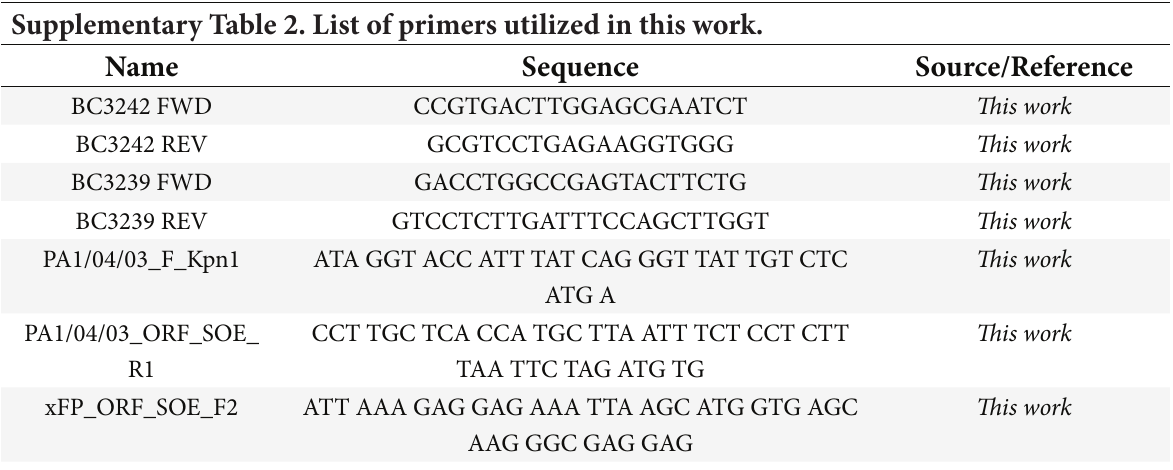
Supplementary Table 2. List of primers utilized in this